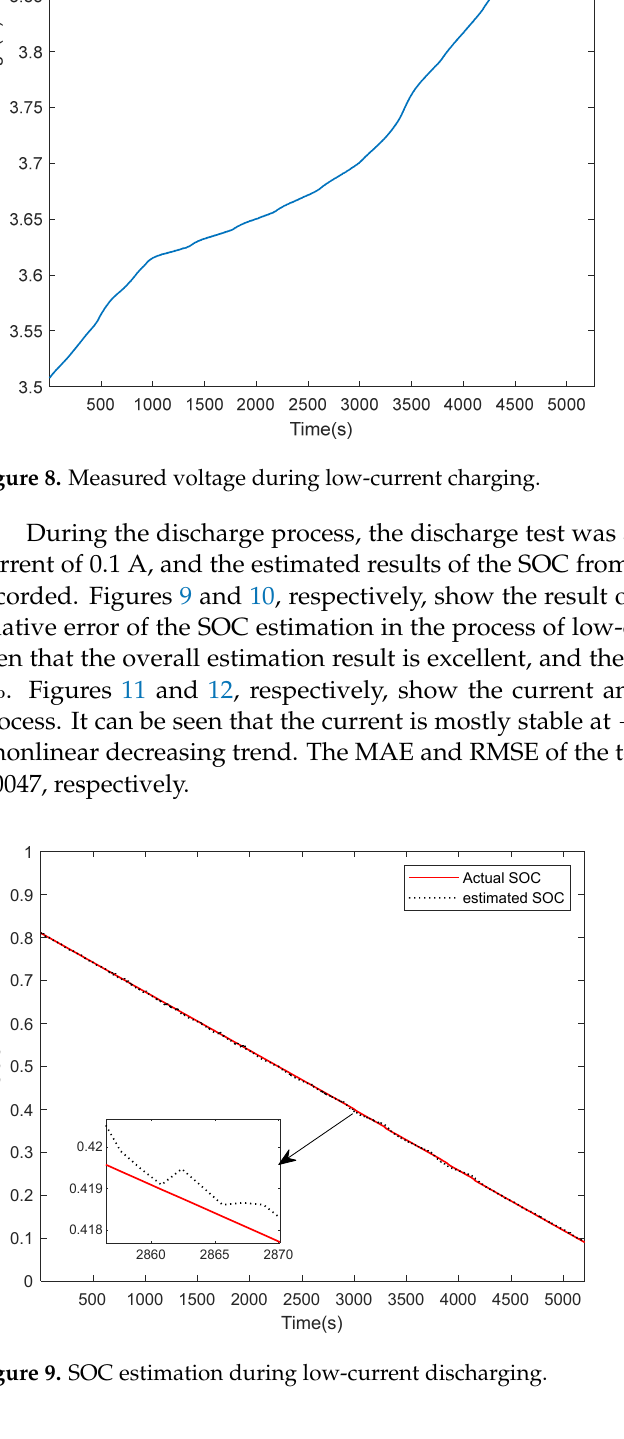
Figure 9. SOC estimation during low-current discharging.